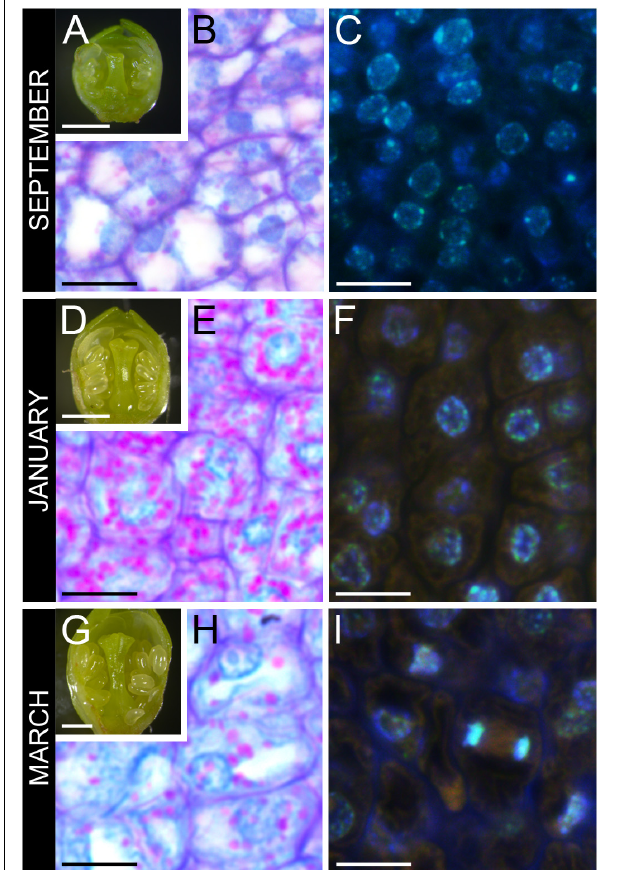
FIGURE 2 | Ovary tissue before, during, and after winter dormancy in sweet cherry flower buds. (A) Flower primordium before dormancy at developmental stage 3, (B) with ovary cells showing little starch, and (C) active nuclei with a spongy appearance. (D) Flower primordium during winter dormancy at developmental stage 4, (E) with cells full of starch, (F) showing condensed nuclei. (G) Flower primordium after winter dormancy at developmental stage 5, (H) with vacuolated cells with reduced starch, and (I) mitotic activity. Bars (A,D,G) 500 µ m, (B,C,E,F,H,I) 20 µ